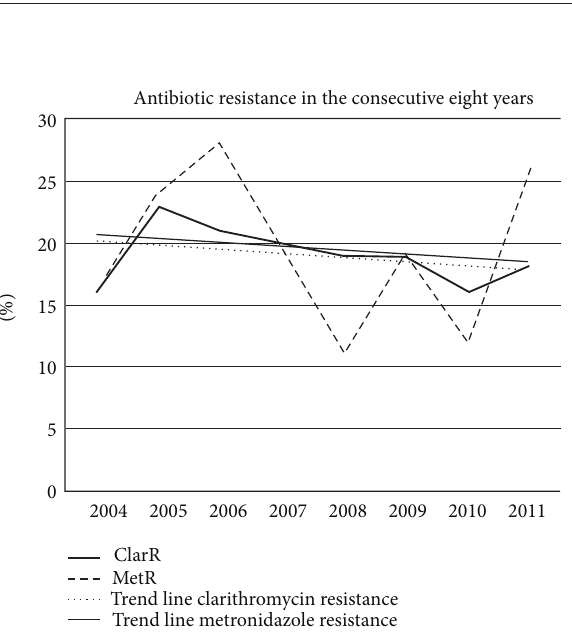
Figure 2: The percentage of susceptible and nonsusceptible strains in the consecutive eight years. ClarR: resistance for clarithromycin, MetR: resistance for metronidazole.